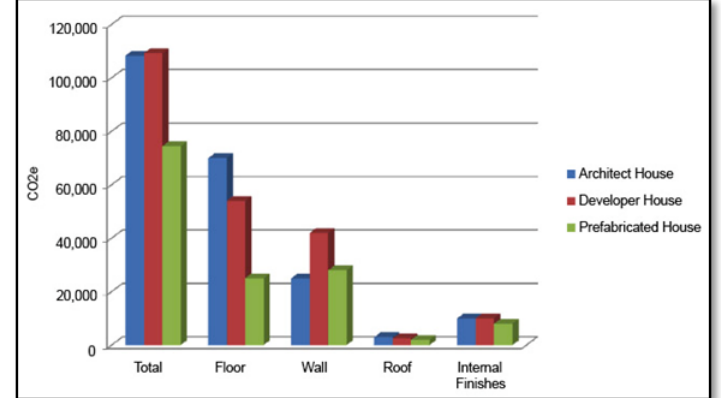
Figure 7: CO2e of materials in each